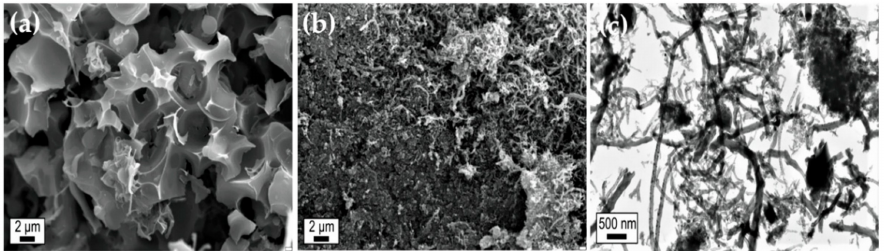
Figure 10. SEM micrograph of ( a ) a fresh 20% Pd/AC sample, ( b ) a 20%Pd/AC sample after the reaction at 850 ◦ C, and ( c ) a TEM micrograph of a 20% Pd/AC sample after the reaction at 850 ◦ C; reprinted with permission from ref. [95]. Copyright 2015 Elsevier.